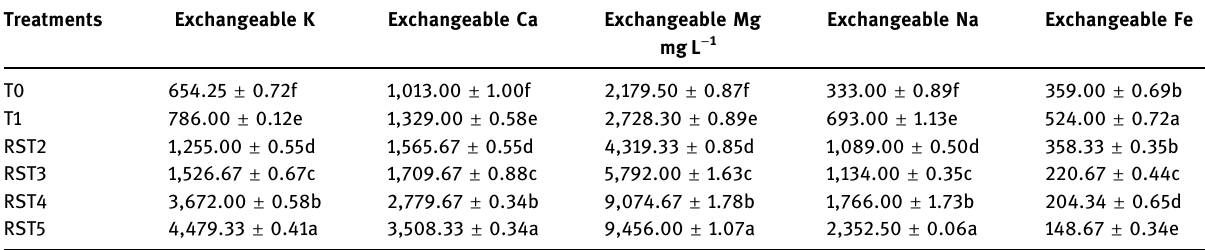
Note: Mean values within column with di ff erent letter ( s ) indicate signi fi cant di ff erence between treatments by Tukey ’ s test at P ≤ 0.05. Columns represent the mean values ± SE.